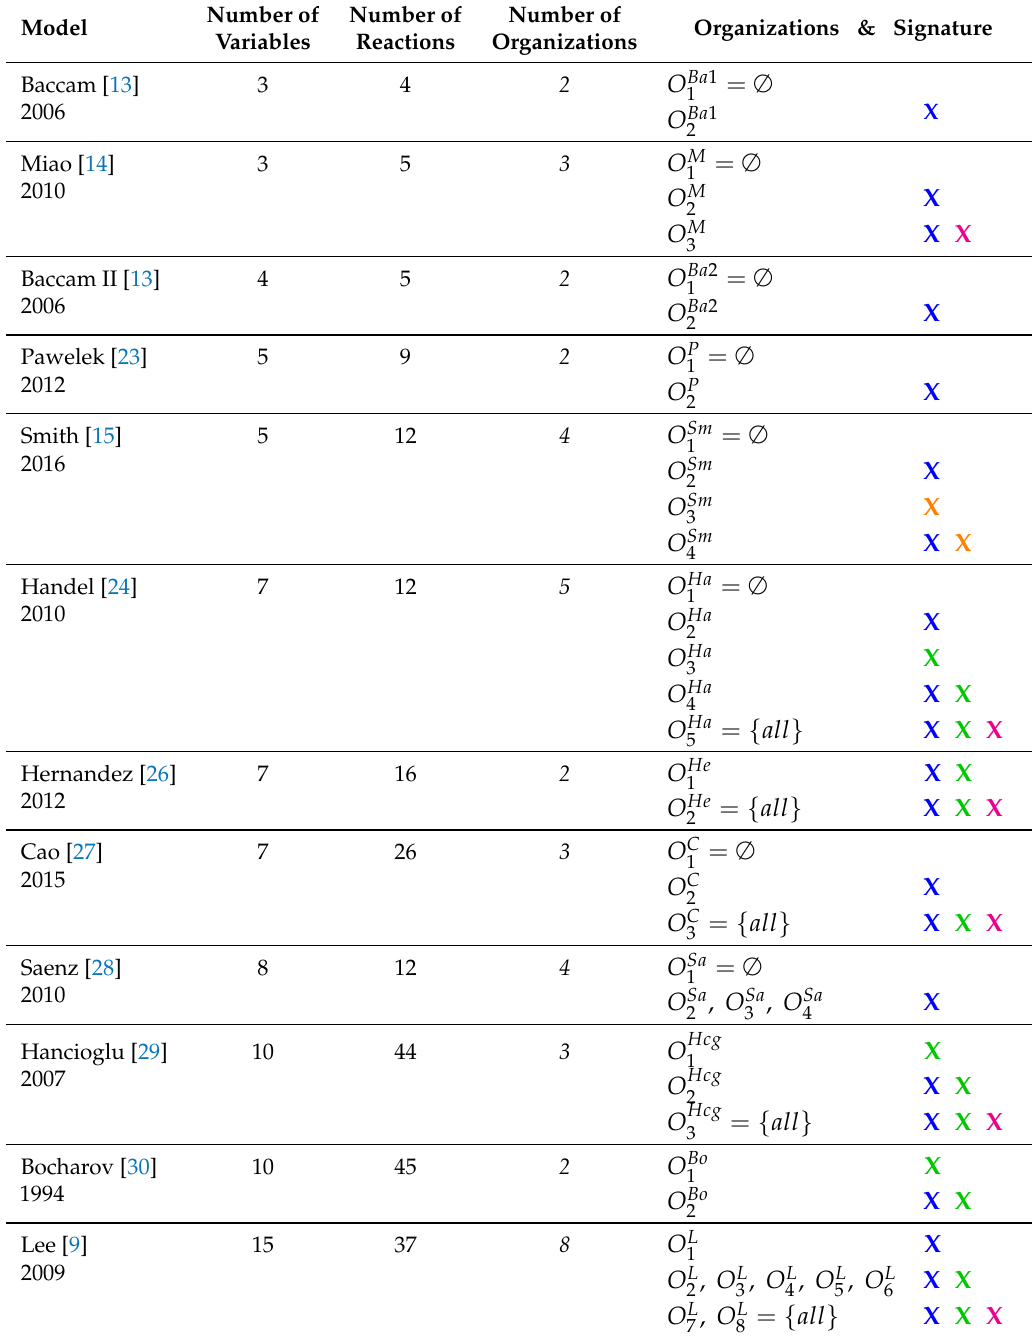
Table 1. Overview of all models and organization types contained. An organization type like XX denotes the type of species contained in an organization, according to our coloring scheme. The set of organization types of a model is called its